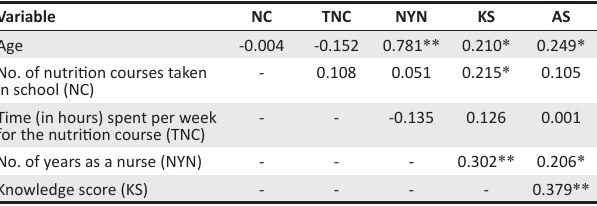
TABLE 6: Spearman’s nonparametric correlation of factors associated with knowledge and attitude